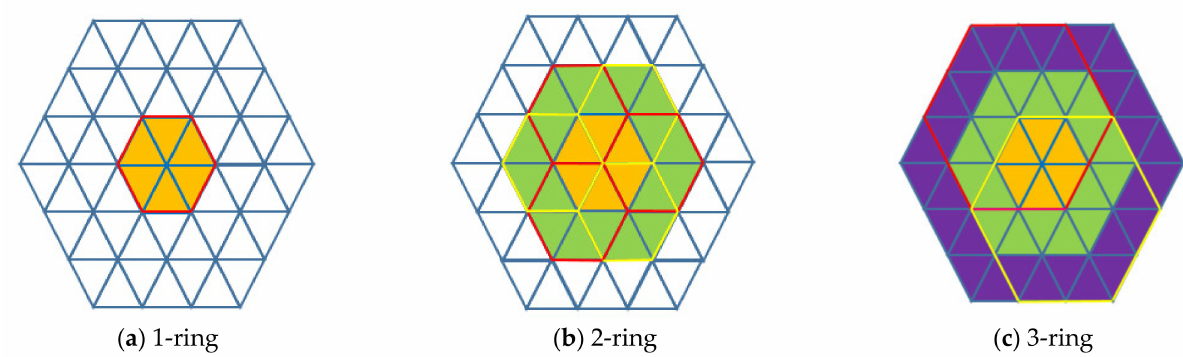
Figure 3. The schematic diagram of the k-ring neighborhood and hierarchical index relationship. The orange region is the 1-ring neighborhood of the center point ( a ) 1-ring, the green region is the expansion of the 2-ring neighborhood compared to the 1-ring neighborhood, and the purple region is the expansion of the 3-ring neighborhood compared to the 2-ring neighborhood. In ( b ), the 2-ring neighborhood can be covered by six 1-ring neighborhoods (three red boxes and three yellow boxes), and in the same way, the 3-ring neighborhood in ( c ) can be covered by six 2-ring neighborhoods (only one red box and one yellow box are drawn for aesthetic purposes).